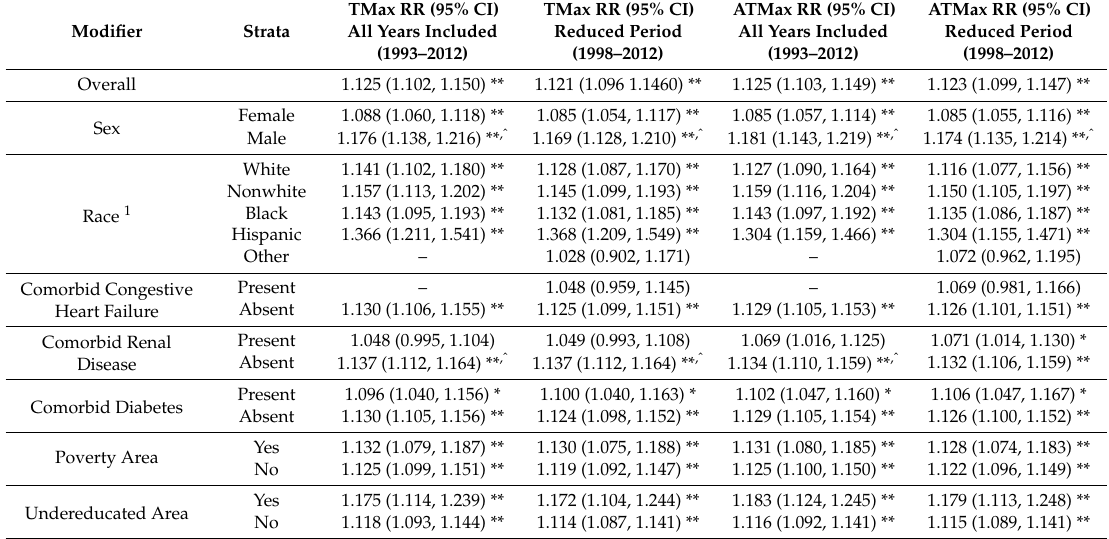
Table 5. Estimated rate ratios for fluid and electrolyte imbalance ED visits in relation to a change of approximately 1 IQR (from the 25th to 75th percentile) for TMax (27 ◦ C to 32 ◦ C) and ATMax (28 ◦ C to 33 ◦ C) in Atlanta during the warm seasons (May–September), 1993–2012 ( n = 3060 days) and 1998–2012 ( n = 2295 days).